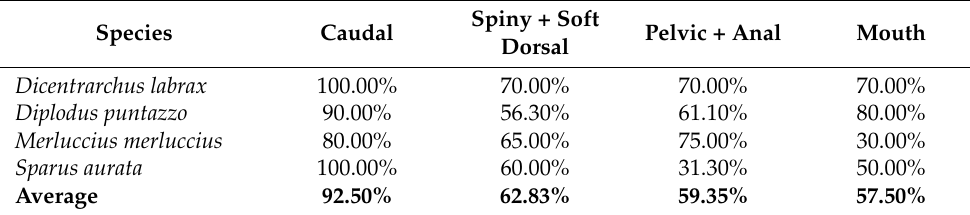
Table 4. Fish part localization for the image processing approach of Figure 1.